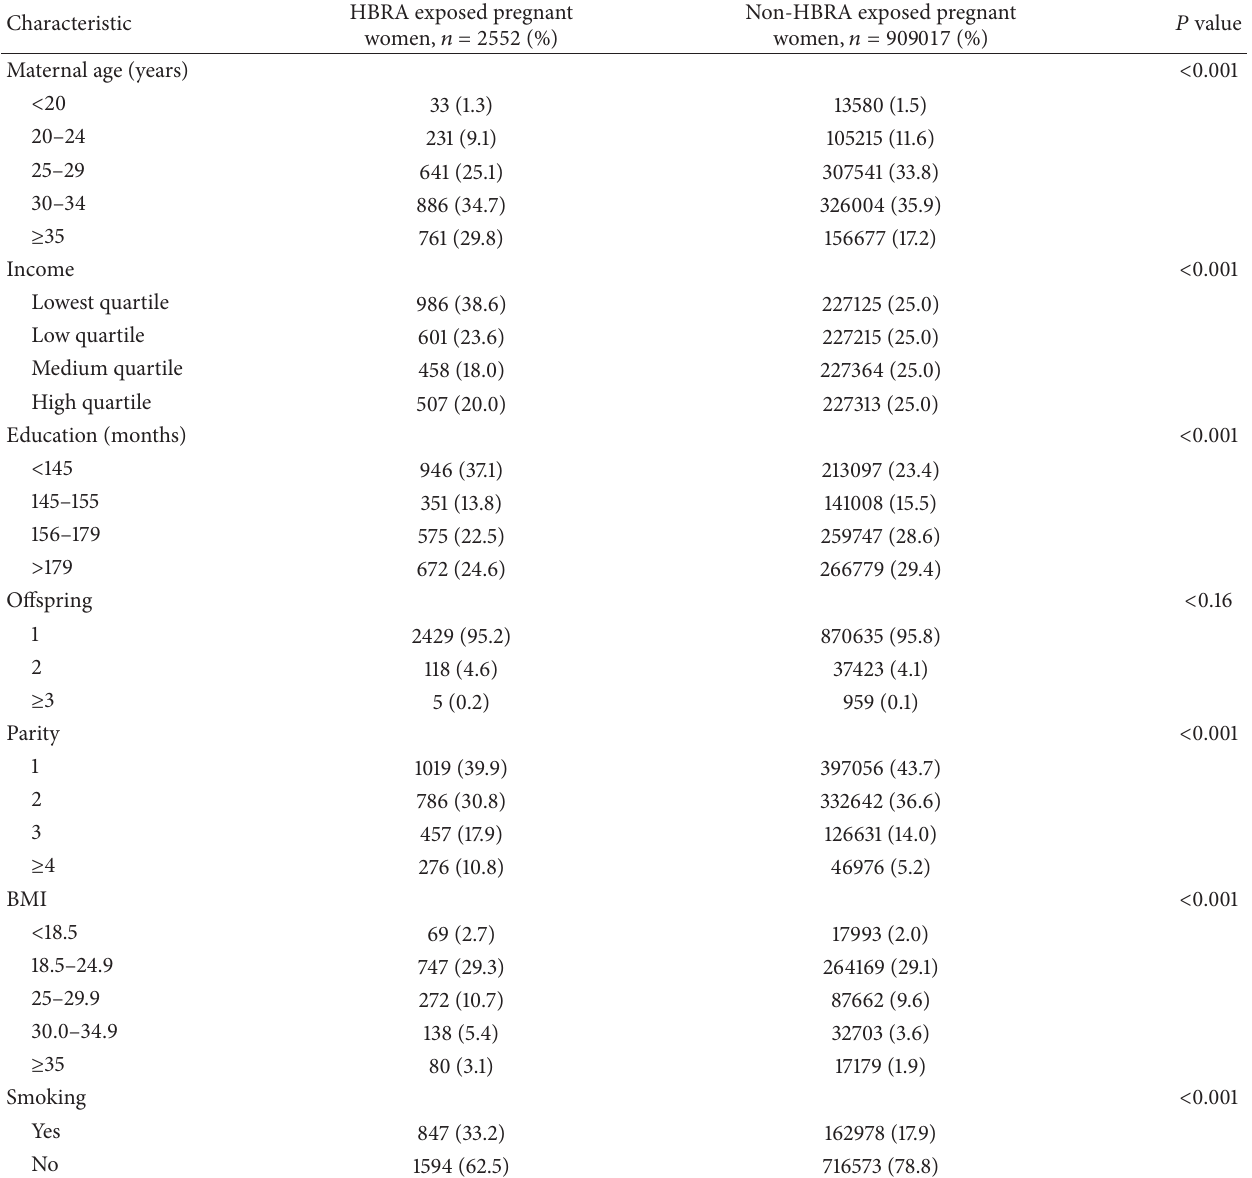
Table 1: Characteristics of women exposed to hypnotic benzodiazepine receptor agonists (HBRA) during pregnancy. Characteristic